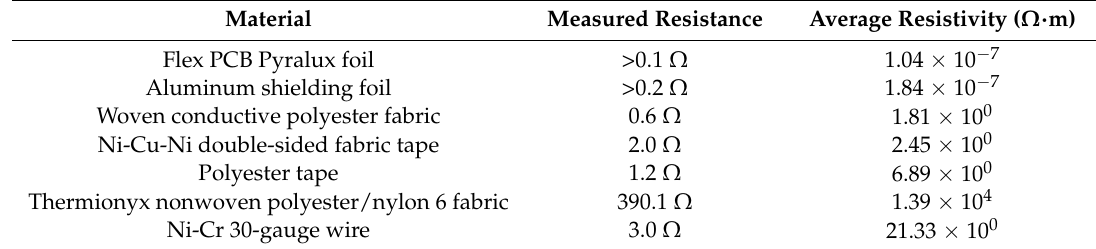
Table 4. 140 mm Strip/Wire Electrical Resistance vs.